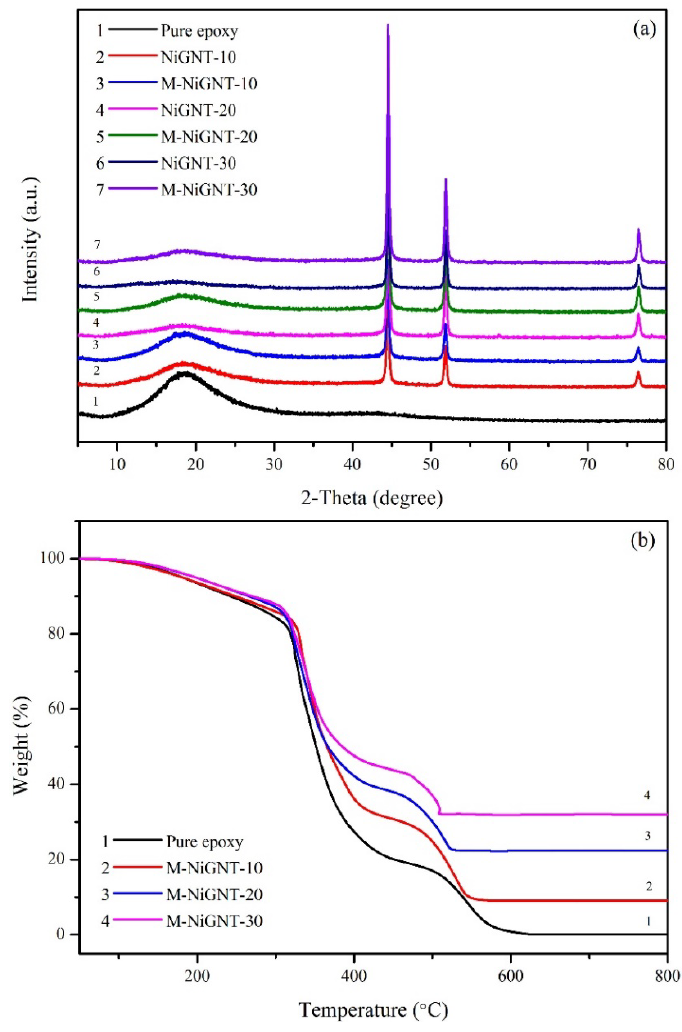
Figure 6. XRD patterns ( a ) and TGA ( b ) curves of the epoxy-based composites.